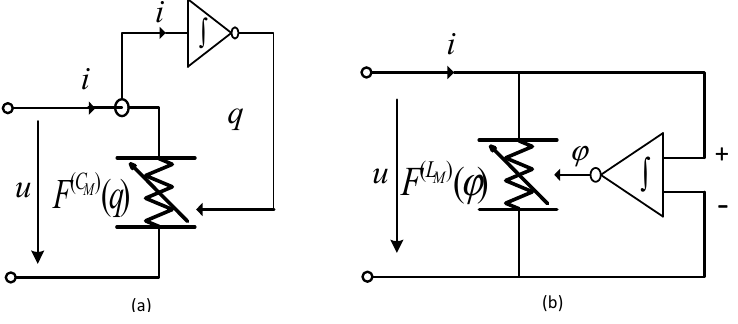
Figure 3. Schematic diagrams of CCFM and VIFM: ( a ) CCFM; and ( b ) VIFM.